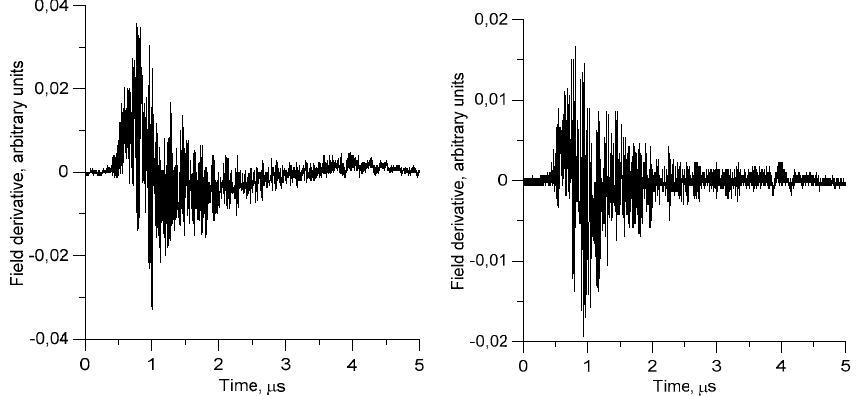
Figure 2 . Two examples of the time derivative of NBPs (Narrow Bipolar Pulses) observed in the study conducted by Gunasekara et al. [11]. Note that the vertical scale is in arbitrary units. Interferometric observations show that CIDs are involved with electrical activity that propagates over a rather short distance, several hundred meters or so, with speeds in the range of 3 × 10 7 to 10 8 m/s with the upper theoretical bound being the speed of light [18].